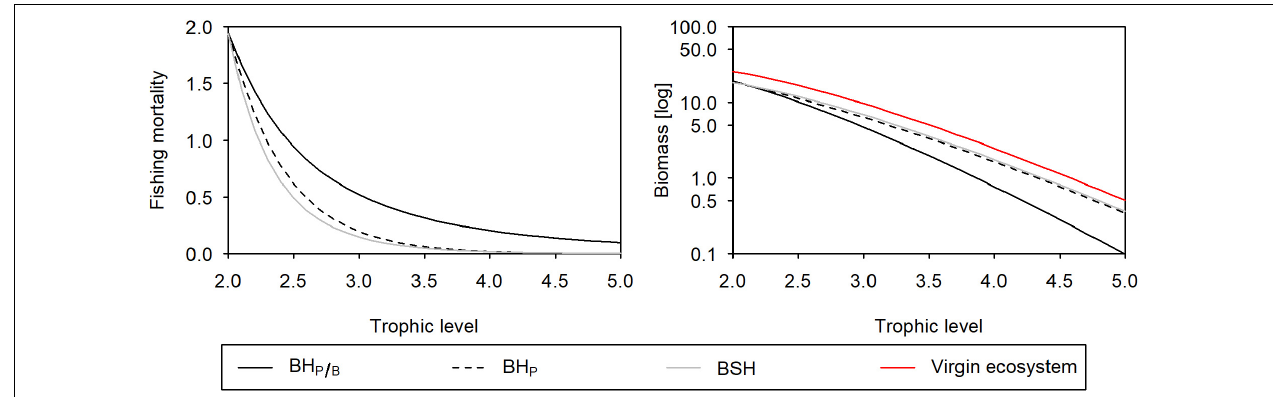
FIGURE 2 | Fishing pattern ( left panel) and biomass (log transformed) trophic structure ( right panel) when balancing fishing mortality with productivity (black solid line), production (black dashed line), and when applying a fishing mortality that fully maintains the biomass structure (gray solid line). The red line in the biomass trophic spectrum represents a multiplier of 0 (virgin